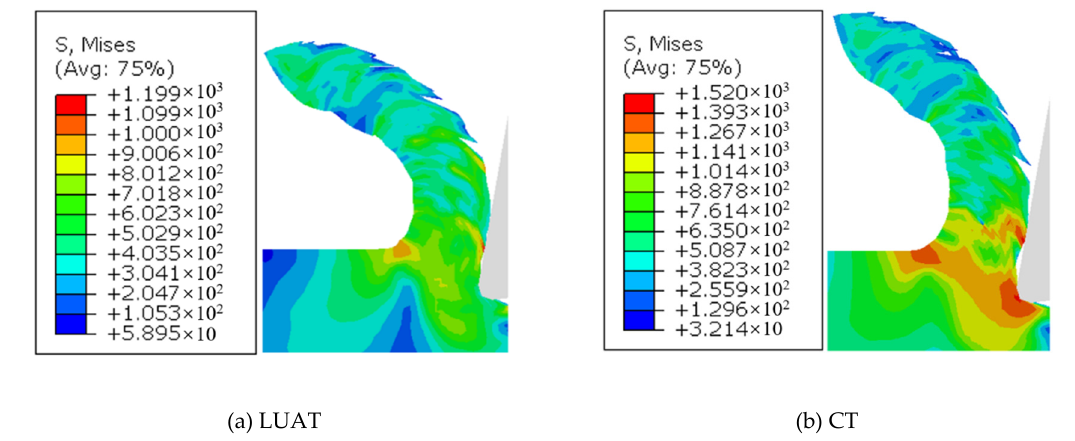
Figure 14. Shapes and von Mises stress in chips. ( a ) LUAT; ( b ) CT.